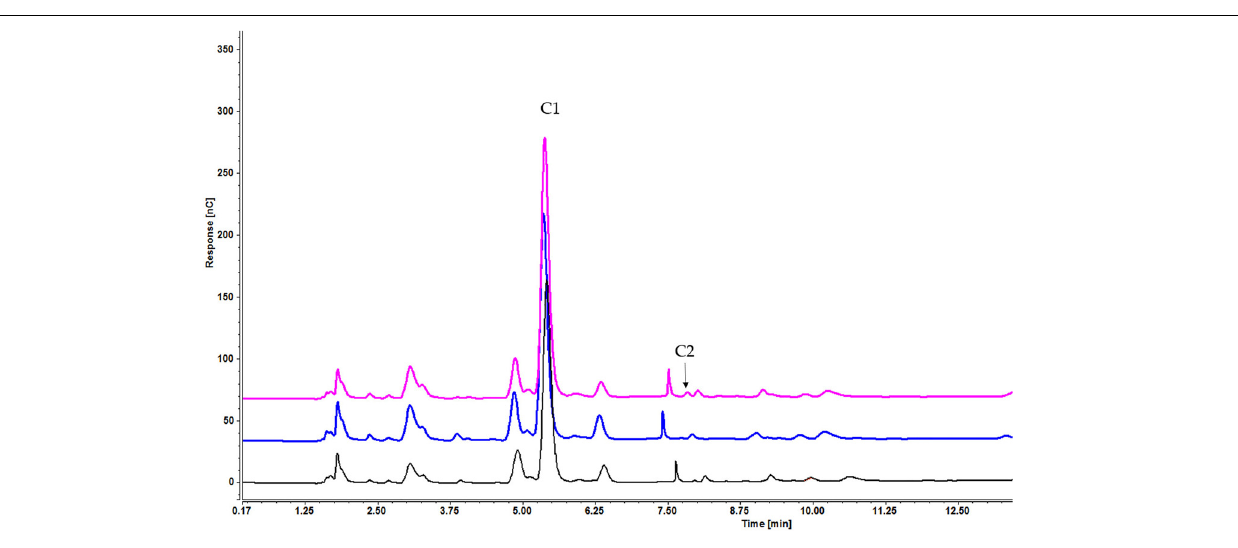
FIGURE 7 | Intracellular concentration of cellooligosaccharides after 1 h of induction by cellobiose (pink), cellotetraose (black), and cellohexaose (blue) (C1 = glucose, C2 =